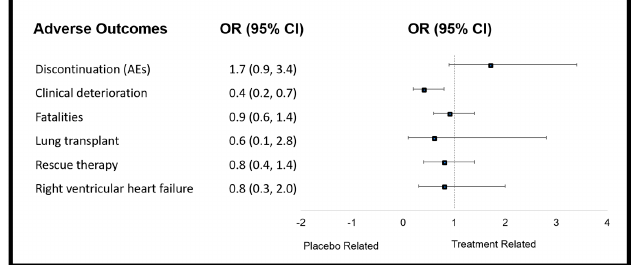
Figure 4. Forest plot showing the overall changes in efficacy measures of prostacyclin mimetic therapy as determined by odds ratio.